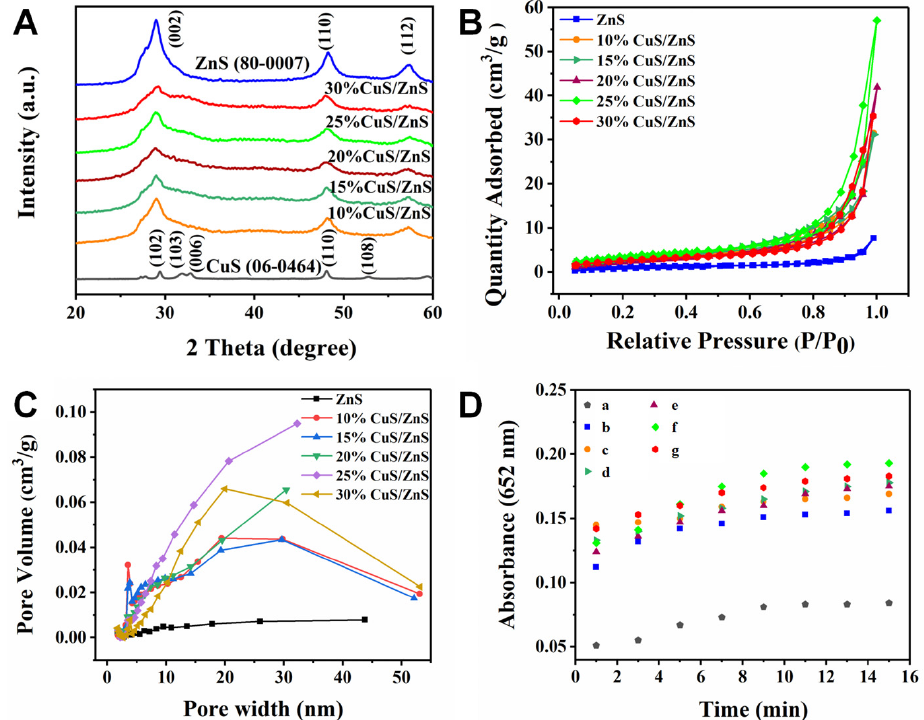
Figure 3. ( A ) XRD patterns of the CuS monomer, the CuS/ZnS composites with 10%, 15%, 20%, 25%, and 30% CuS, and the ZnS monomer; the JCPDS card numbers for ZnS and CuS are 80-0007 and 06-0464, respectively; ( B ) N 2 adsorption–desorption isotherms and ( C ) pore size distribution curve of the ZnS monomer and the CuS/ZnS composites; ( D ) time-dependent changes in enzyme activity of different catalysts (a. Blank; b. ZnS; c–g. CuS/ZnS composites with 10%, 15%, 20%, 25%, and 30% CuS).